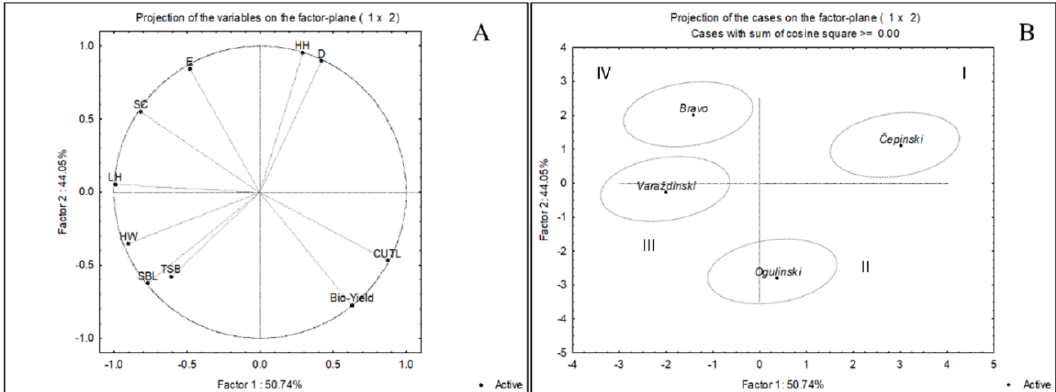
Figure 1. Principal component analysis of studied cabbage cultivars using morphological and physical traits. Factor loadings ( A ) and scores ( B ) of first two factors. Head hight (HH), head width (HW), distance from the top of steam base to the top of the head (D), steam base length (SBL), thickness of steam base (TSB), Bio-Yield point (Bio-Yield), leaves hardness (LH), elasticity (E), surface colour greenness (SC), and colour underneath two leaves greenness (CUTL).